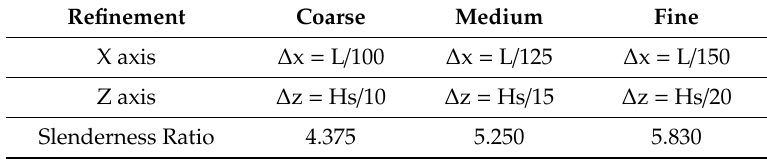
Table 2. Mesh configuration of 3 mesh density under the focused wave.